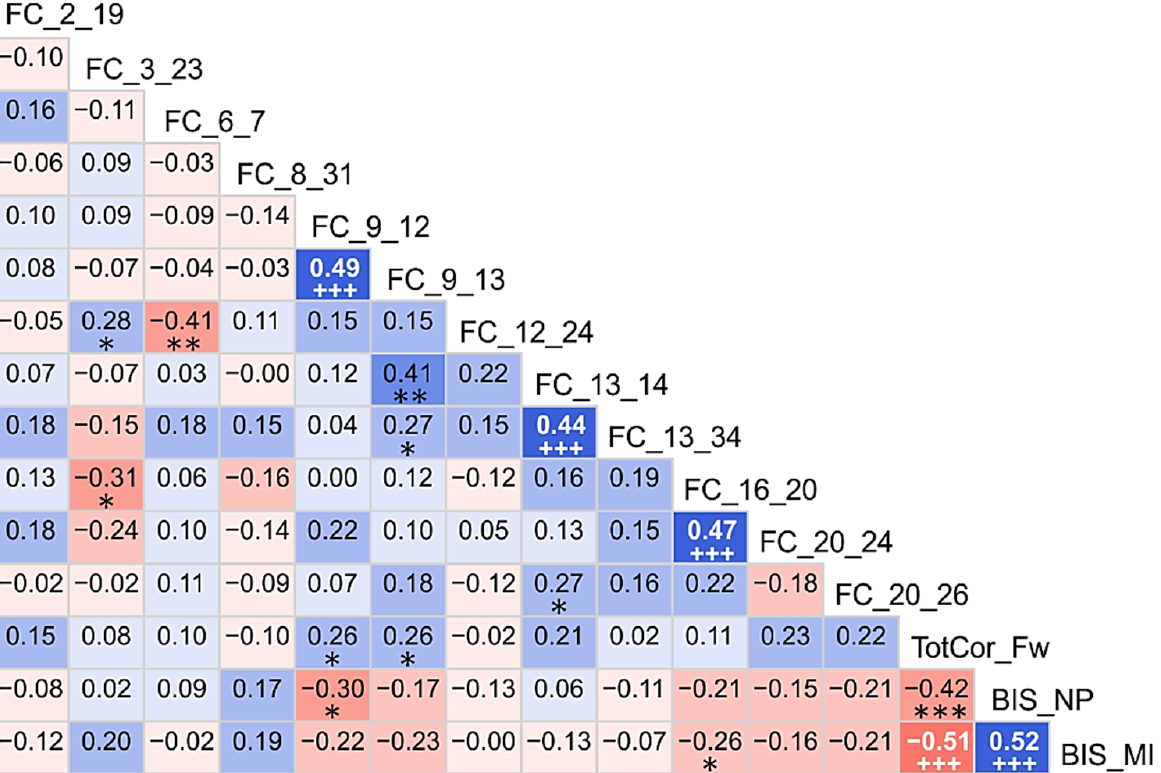
Figure 8. Correlation matrix showing associations among the top significant variables based on explorative (descriptive) correlational analysis for the interpretative purpose. Values within each cell represent a bivariate Pearson correlation between the variable on its vertical axis and the variable on its horizontal axis. Correlation coefficients are color-coded (red/pink shades represent negative r-values, blue/cyan shades indicate positive r-values, darker color represent higher magnitude) and significant correlations (before Bonferroni correction) have been marked with asterisks in black font (* p < 0.05; ** p < 0.01; *** p < 0.001). The significant correlations that survived Bonferroni correction have been marked with +++ sign in white font (+++ Significant after Bonferroni correction ). Refer to Table 2 for details about the ROI numbers (1–34) that are represented in the rsFC variable names.